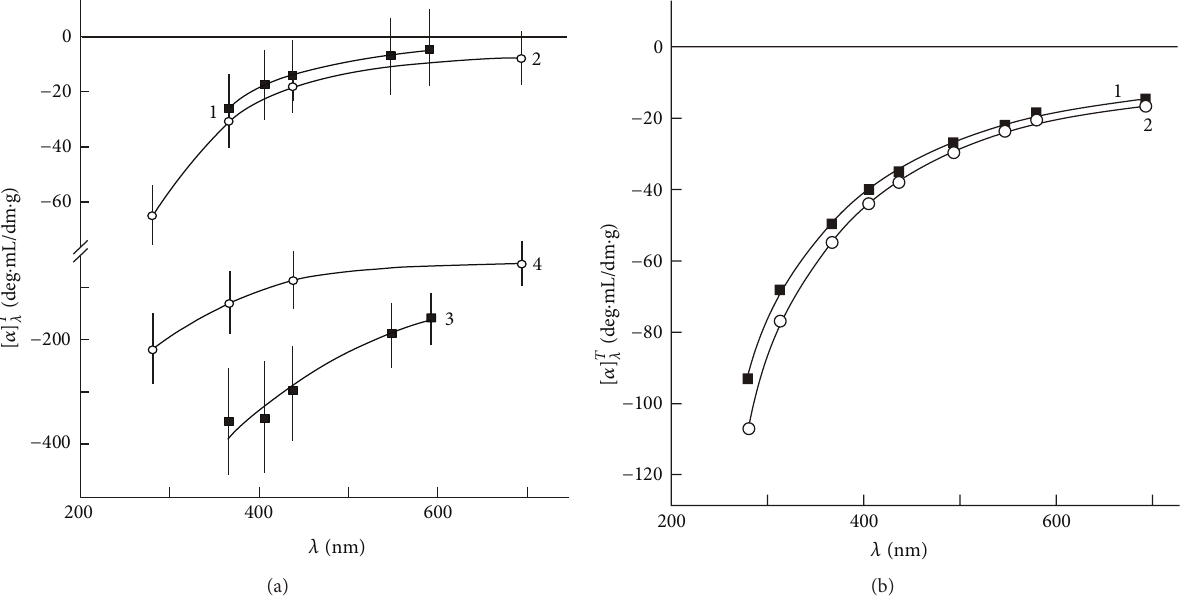
Figure 1: (a) ORD curves for CTS-87 (1, 3) and CTS-640 (2, 4) films in the acetic (1, 2) and basic (3, 4) forms, as recorded on PolAAr 3001 (1, 3) and SPU-E (2, 4) spectropolarimeters. The moisture content of the film samples was 22 ± 2 (1) and 12 ± 1 wt.% (2). Vertical bars show the variation range of [𝛼] values for different orientation angles of the film sample. (b) ORD curves of 0.5% solutions of CTS-87 (1) and CTS-640 (2) in 2% acetic acid, as recorded on an SPU-E spectropolarimeter